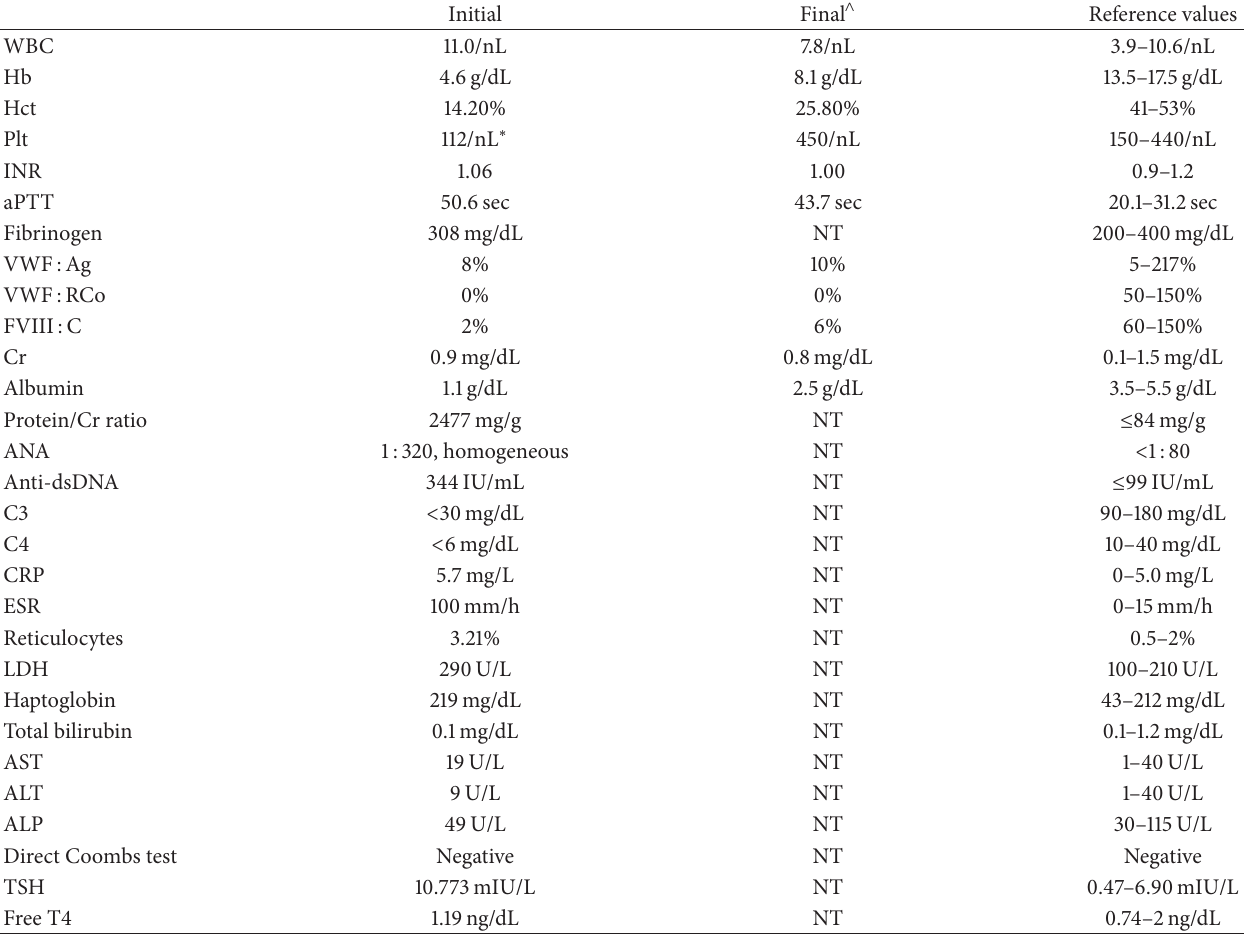
Table 1: Laboratory data of